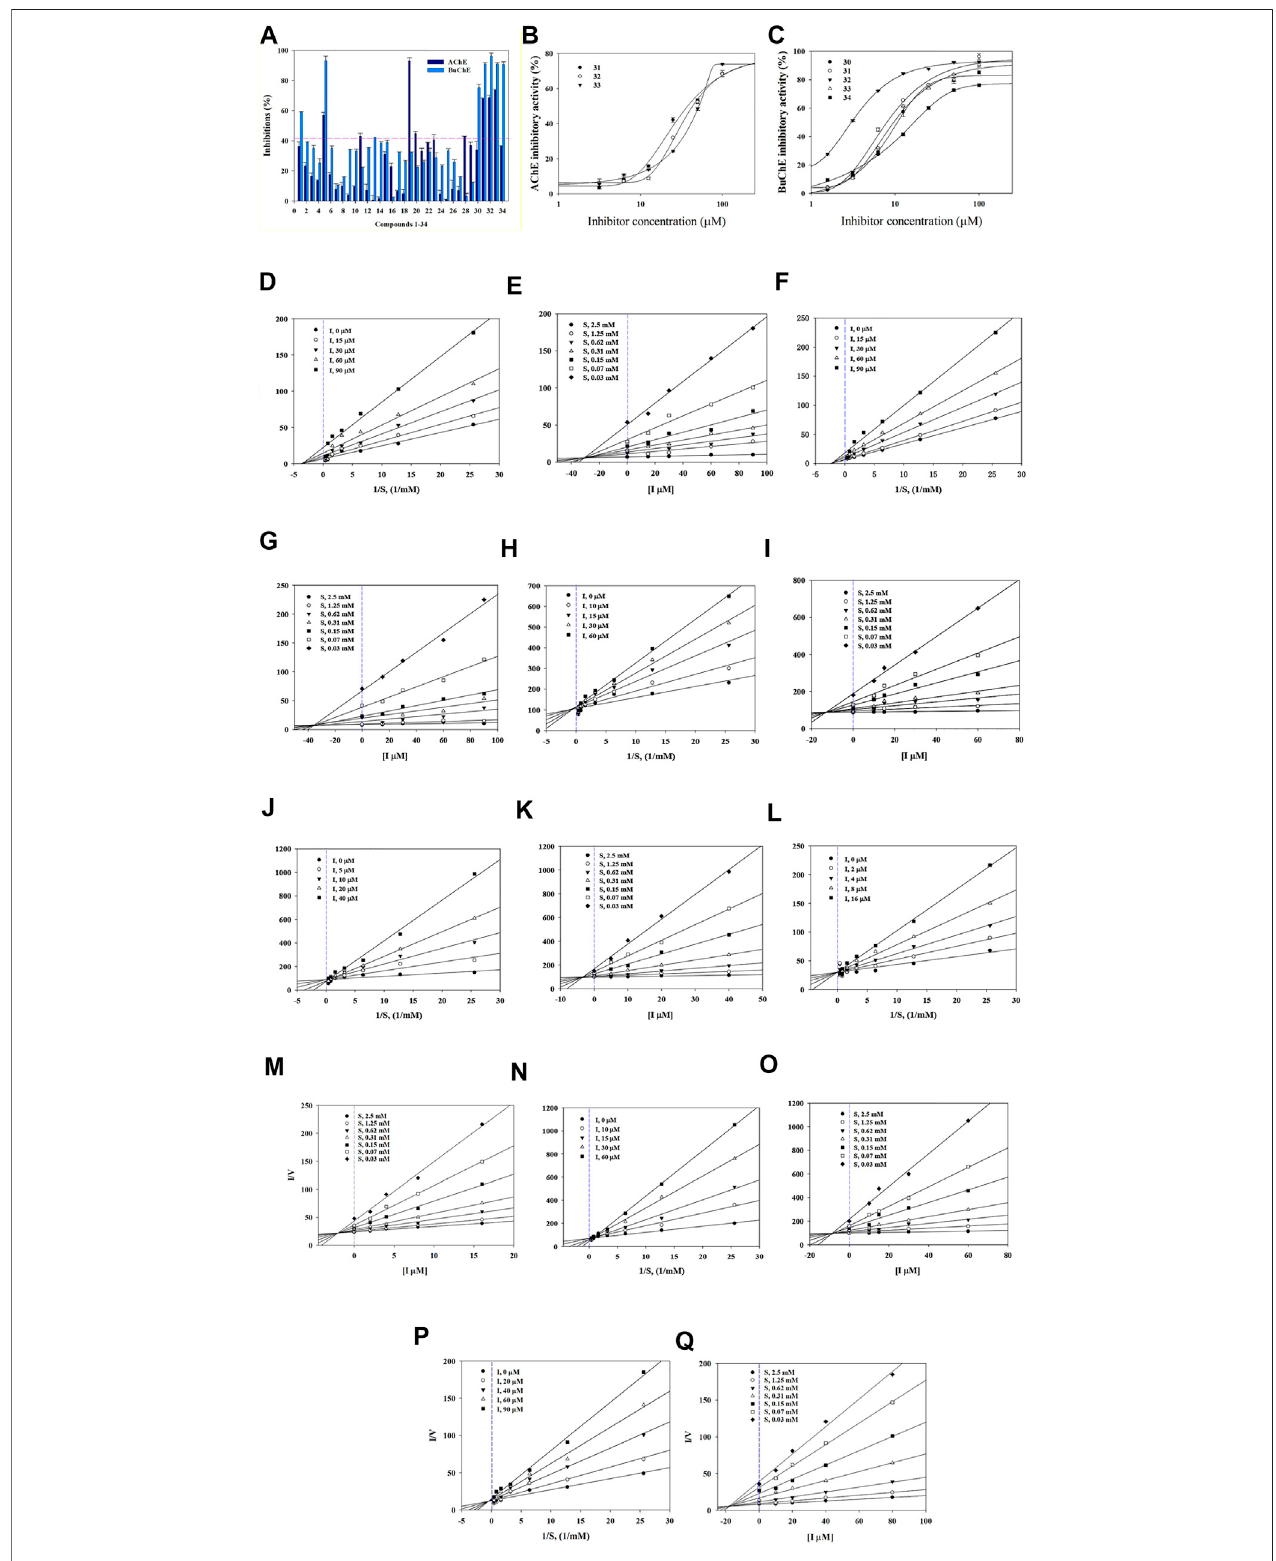
FIGURE2| Inhibitoryactivityofcompounds 1 – 34 at100 µMtowardsAChEandBuChE (A) .IC 50 valuesof 31 – 33 onAChE (B) and 30 – 34 BuChE (C) .Lineweaver- Burkplots (D,F) andDixonplots (E,G) ofcompounds 31 and 32 onAChE.Lineweaver-Burkplots (H,J,L,N,P) andDixonplots (I,K,M,O,Q) ofcompounds 30 – 34 on BuChE.